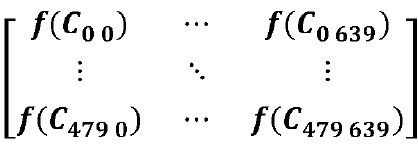
Figure 6. Adjustment Matrix.